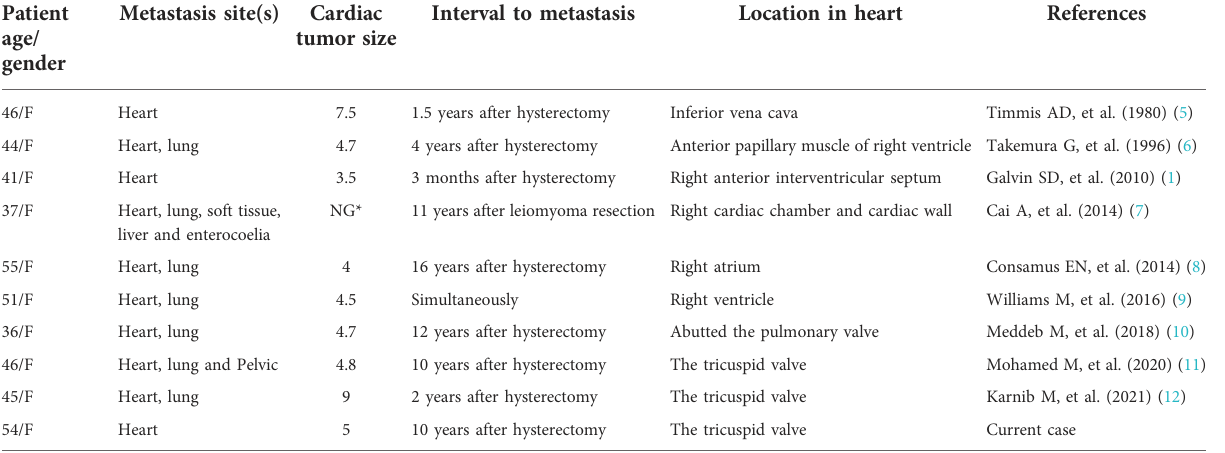
TABLE 1 Summary of case reports of metastasizing leiomyoma in the